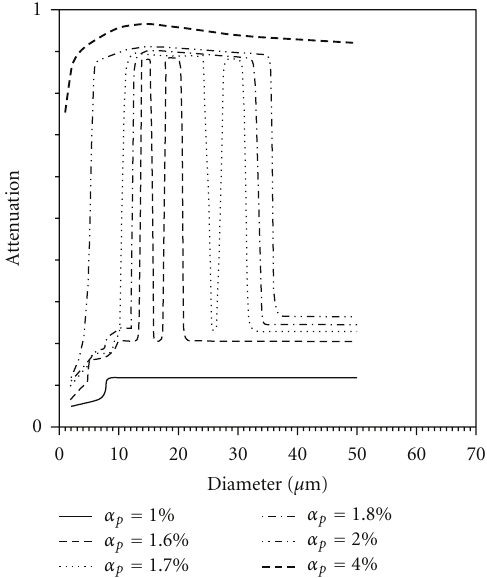
Figure 10: Nondimensional attenuation as function of particle diameter and loading of a single particle set, reference motor, acceleration